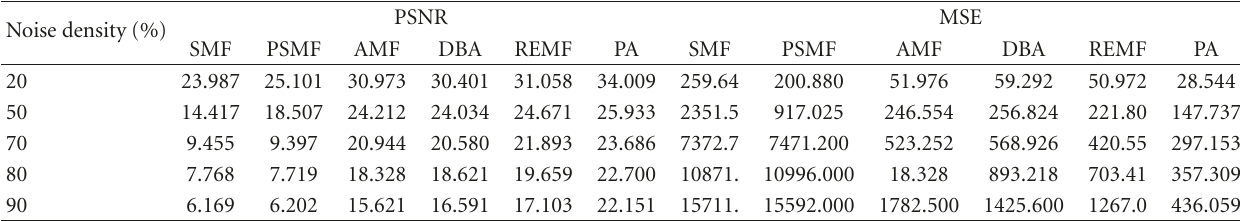
Table 5: PSNR and MSE for various filters for Cameraman image at di ff erent noise